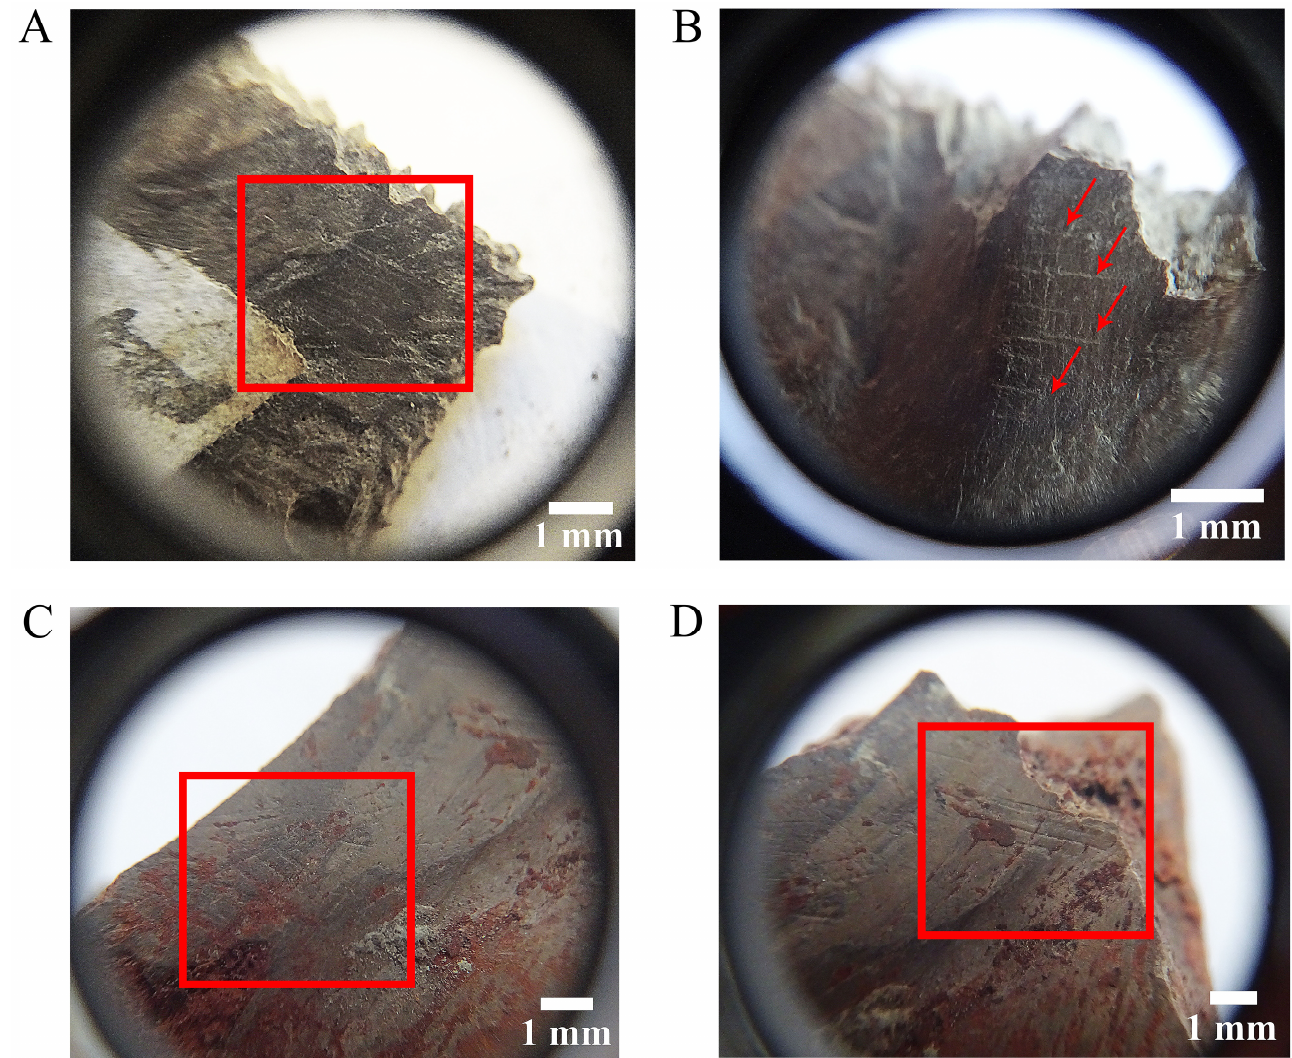
Figure 4. Details of incisions and scratches groups in turtle remains from the Middle Palaeolithic site of Mealhada (Coimbra, central Portugal). Arrows and boxes mark the identified alterations. For each specimen alteration type, see Table 2. Mauremys leprosa right peripheral 10 detail ( A ) and left xiphiplastron detail ( B ). Emys orbicularis right epiplastron detail ( C , D ).